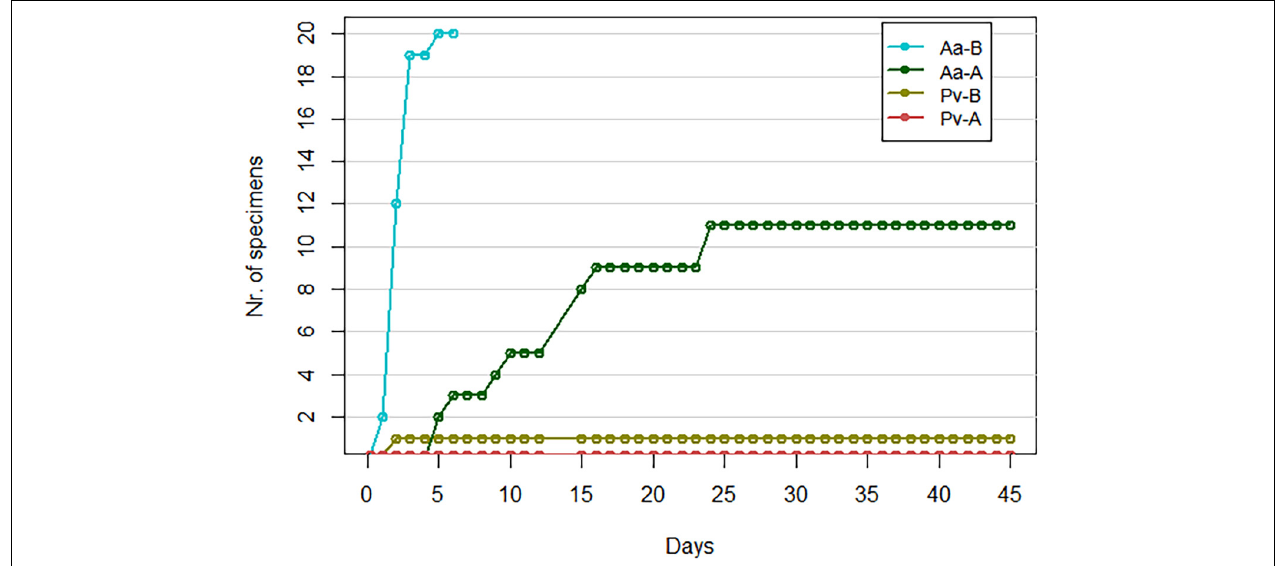
FIGURE 1 | Cumulative number of crayfish showing gross signs of infection. Pv, marbled crayfish; Aa, noble crayfish; A, A. astaci of haplogroup A-challenged crayfish; B, A. astaci of haplogroup B-challenged crayfish.